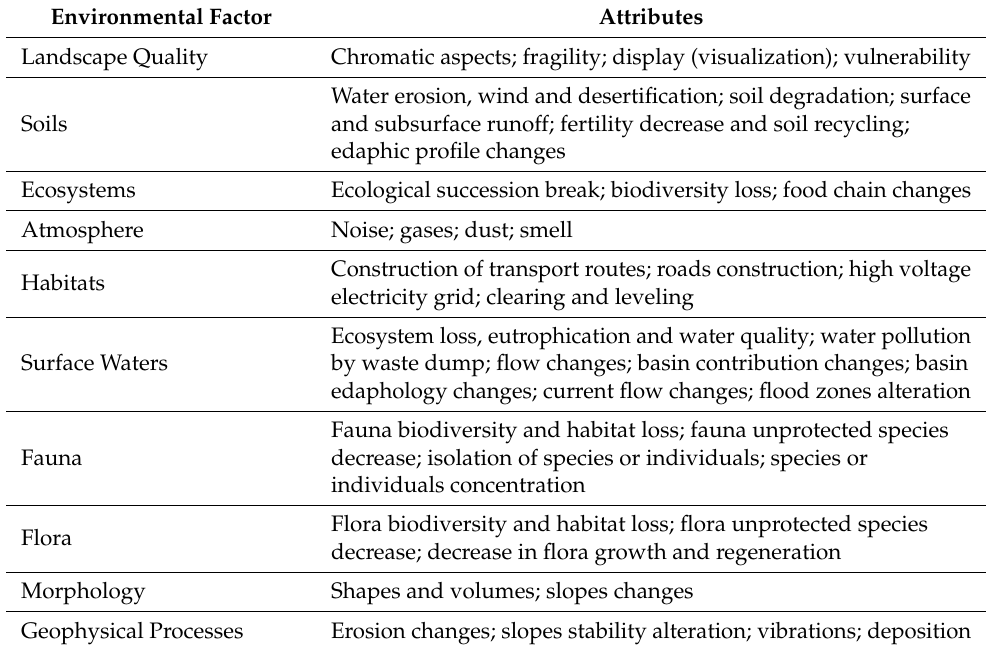
Table 1. Environmental factors and conceptual attributes associated with the study